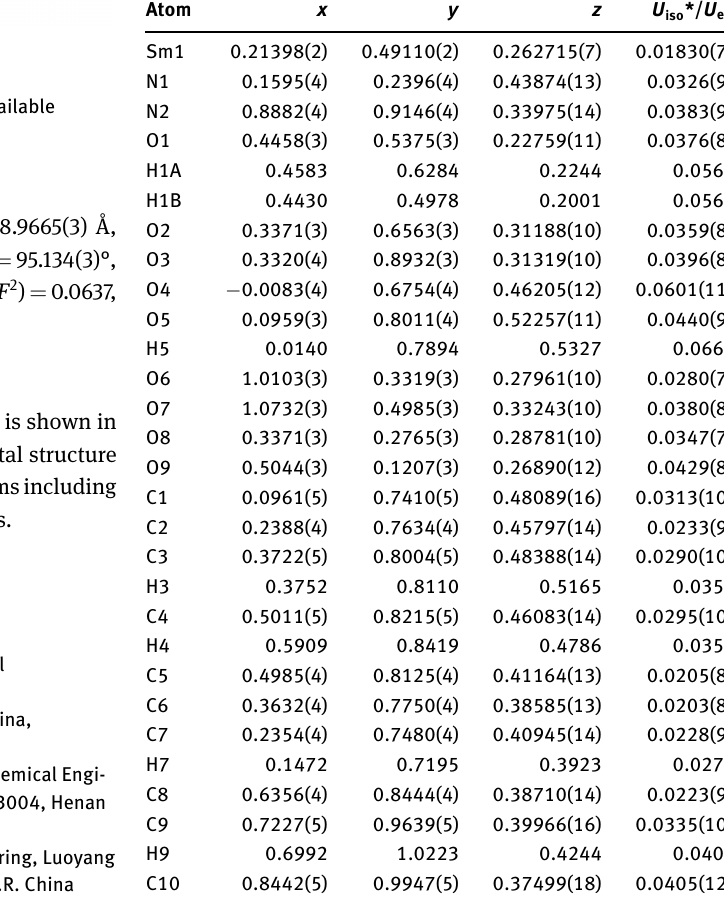
Table 2: Fractional atomic coordinates and isotropic or equivalent isotropic displacement parameters (Å 2